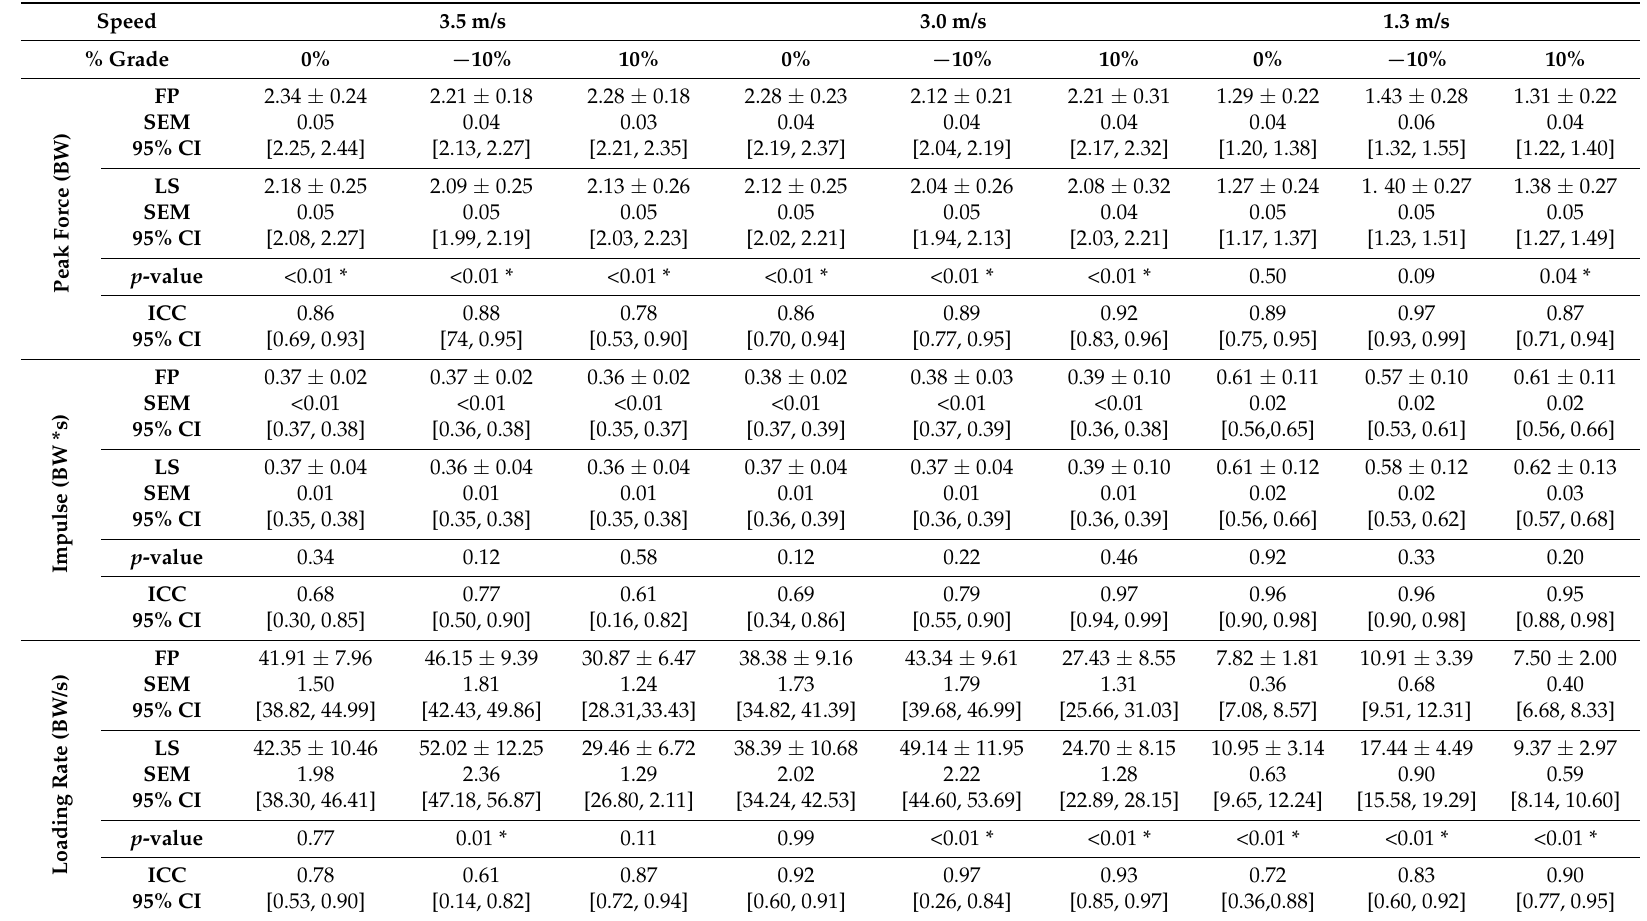
Table 2. Day 1 results of peak force, impulse, loading rate for the force plate (FP) and loadsol ® (LS) are presented along with the standard error of the mean (SEM) and the intraclass correlation coefficients (ICC) with their 95% confidence intervals